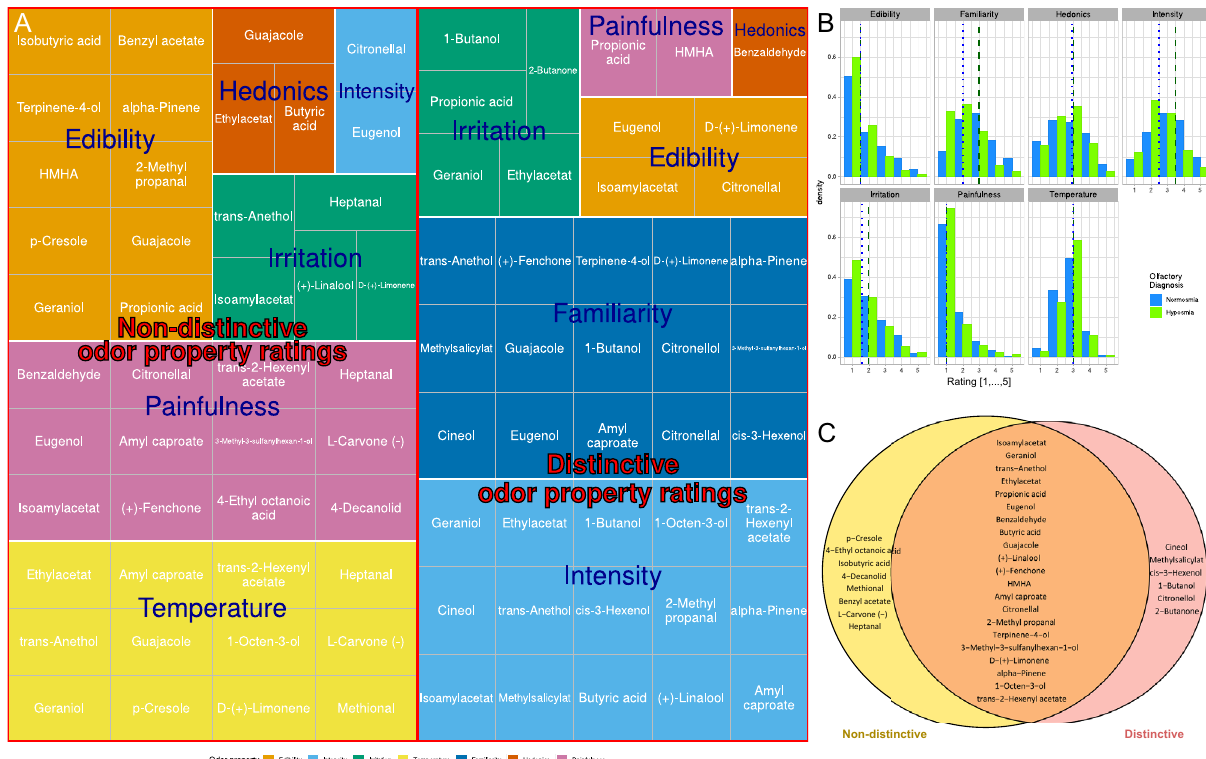
Figure 3. Perceptual ratings of odors that possess properties that are informative for the distinction between normosmic and hyposmic subjects, or that lack such properties. ( A ) Tree map of odor property assessments. The figure is a structured representation of the results of the item categorization analysis in a hierarchical order. The first level represents the grouping of the odor property ratings in terms of the information they provide for distinguishing normosmic from hyposmic subjects. The subsequent levels show perceptual properties and odors separated from each other. The second level represents the perceptual properties. The size of the rectangles corresponds to the number of odors that possess the respective property in connection with the separation of normosmic and hyposmic test persons. The third level represents the individual odors that possess the respective property that has been found to be informative or non-informative for the separation of olfactory diagnoses. ( B ) Histograms of the pooled ratings of seven properties for all odors. The dotted and dashed perpendicular lines mark the medians of the respective ratings, separately for normosmic (dashed) and hyposmic (dotted) subjects. ( C ) Venn diagram showing the sets observed between two groups of odors identified to represent characteristics that best distinguish between olfactory diagnoses or, on the other hand, are least distinctive between olfactory diagnoses (Table 2). The figure has been created using the R software package (version 4.0.3 for Linux; https:// CRAN.R- proje ct. org/ 40 ) and the R libraries RAM” (https:// cran.r-